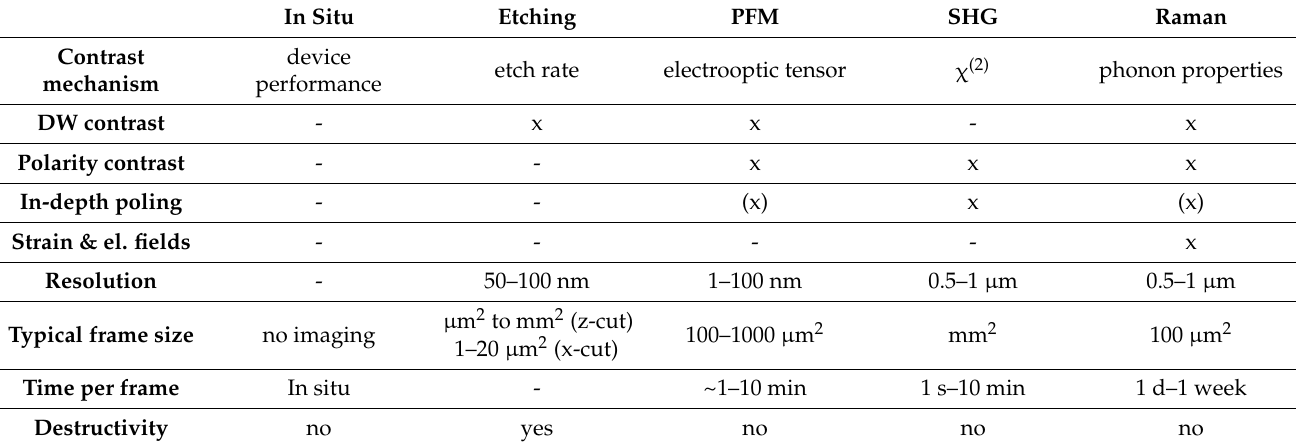
Table 1. Comparison of the techniques applied to the analysis of x-cut TFLN, with respect to the following parameters: Detectable imaging contrasts, contrast mechanisms, spatial resolution, measurement speed, acquisition time, destructive nature of the technique. PFM: Piezoresponse force microscopy; SHG: Second-harmonic-generation microscopy: RS: Raman